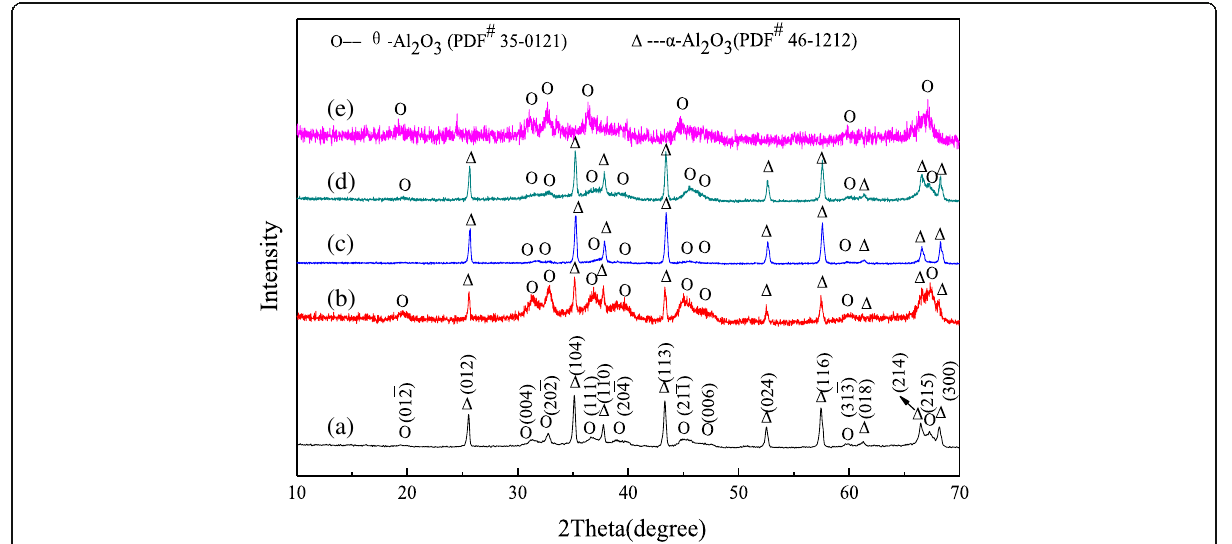
Fig. 1 XRD patterns of alumina nanorods doped with different ions: a undoped alumina, b Cr-doped alumina, c Fe-doped alumina, d Mg-doped alumina, and e the alumina prepared from the chromium-containing alumina